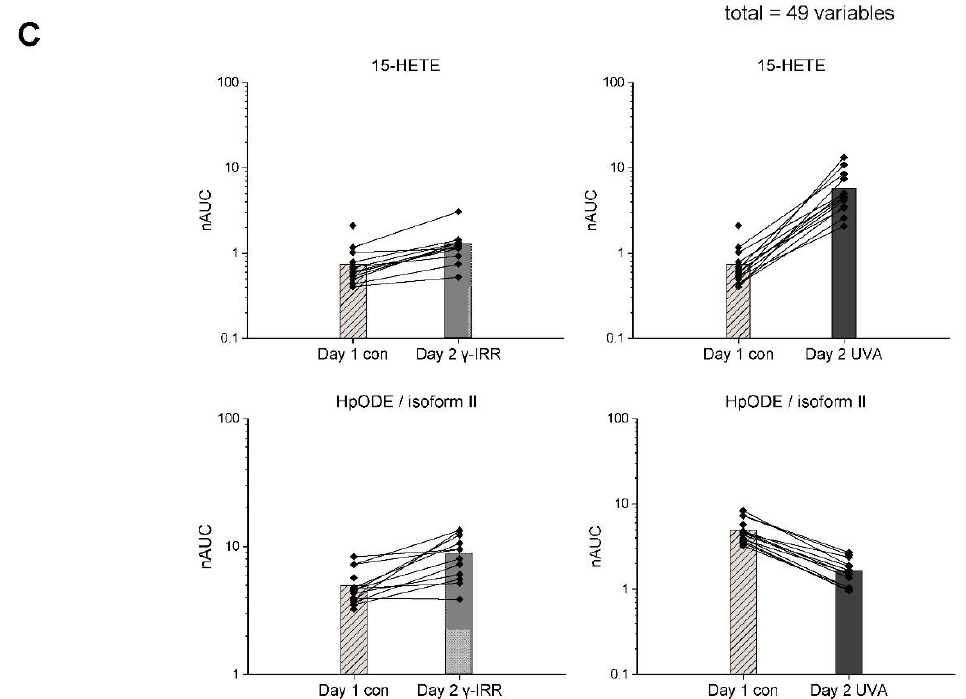
Figure 2. ( A ) INTERCEPT treatment, but not γ -IRR, is accompanied by the formation of trans -arachidonic acid isoforms. ( B ) Immediate effects of INTERCEPT treatment versus γ -IRR at day 2 are displayed as a volcano plot: significant regulations with p -value < 0.05 and log2 fold change (Log2FC) > |1| (red), p -value < 0.05 (blue), Log2FC > |1| (green) and nonsignificant results (grey). ( C ) Uniformity of strong regulatory events upon INTERCEPT treatment in contrast to γ -IRR are shown for 15-HETE and HpODE isoform